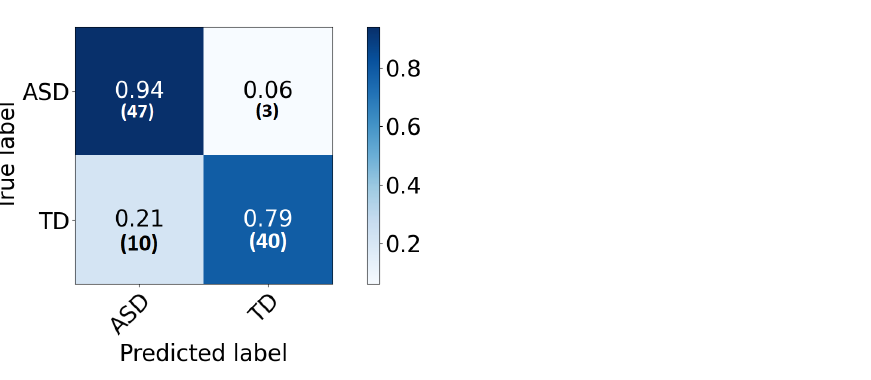
Figure 6. The confusion matrix for the global classifier represented in percentage (number) for each